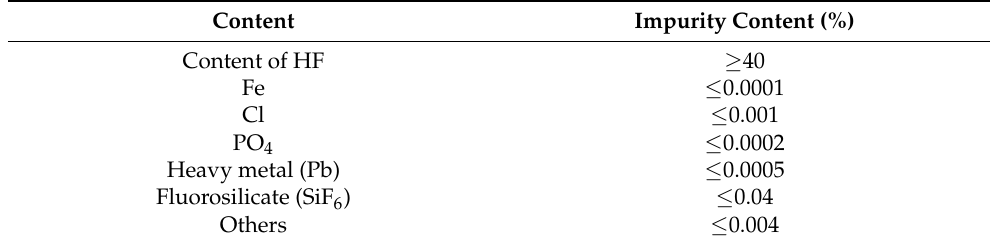
Table 3. The chemical composition of hydrofluoric